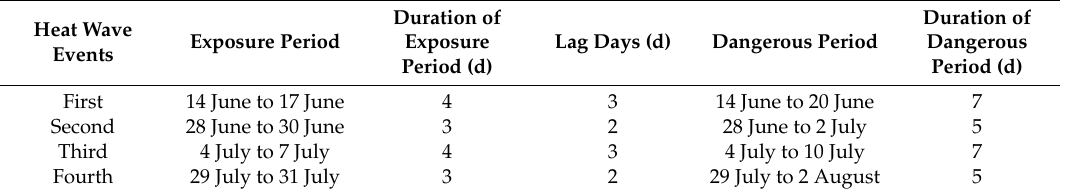
Table 6. The exposure periods of heat wave and their corresponding dangerous periods and duration.